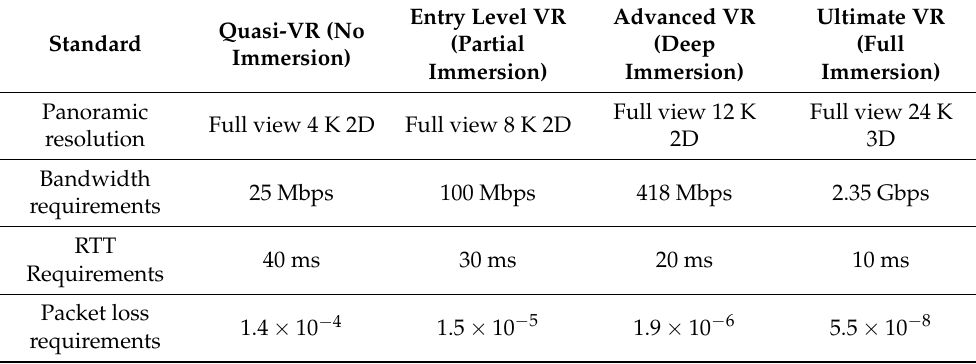
Table 1. Summary of VR 360-degree video network application